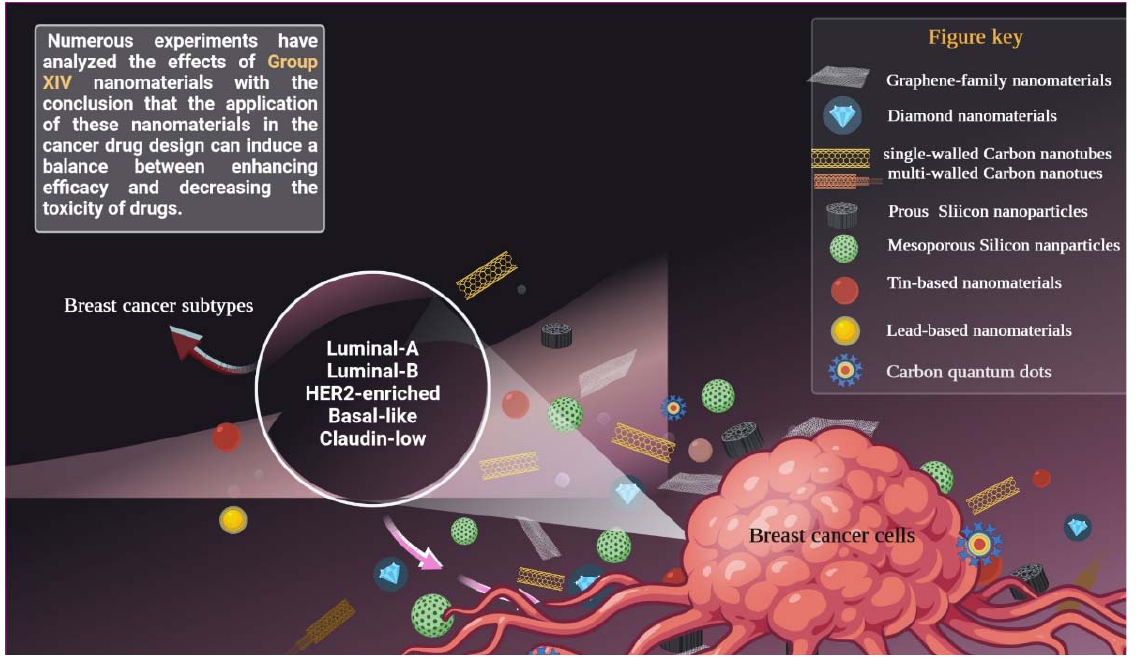
Figure 1. Nanomaterials derived from G14 whose antiproliferative effects on breast cancer subtypes were established.